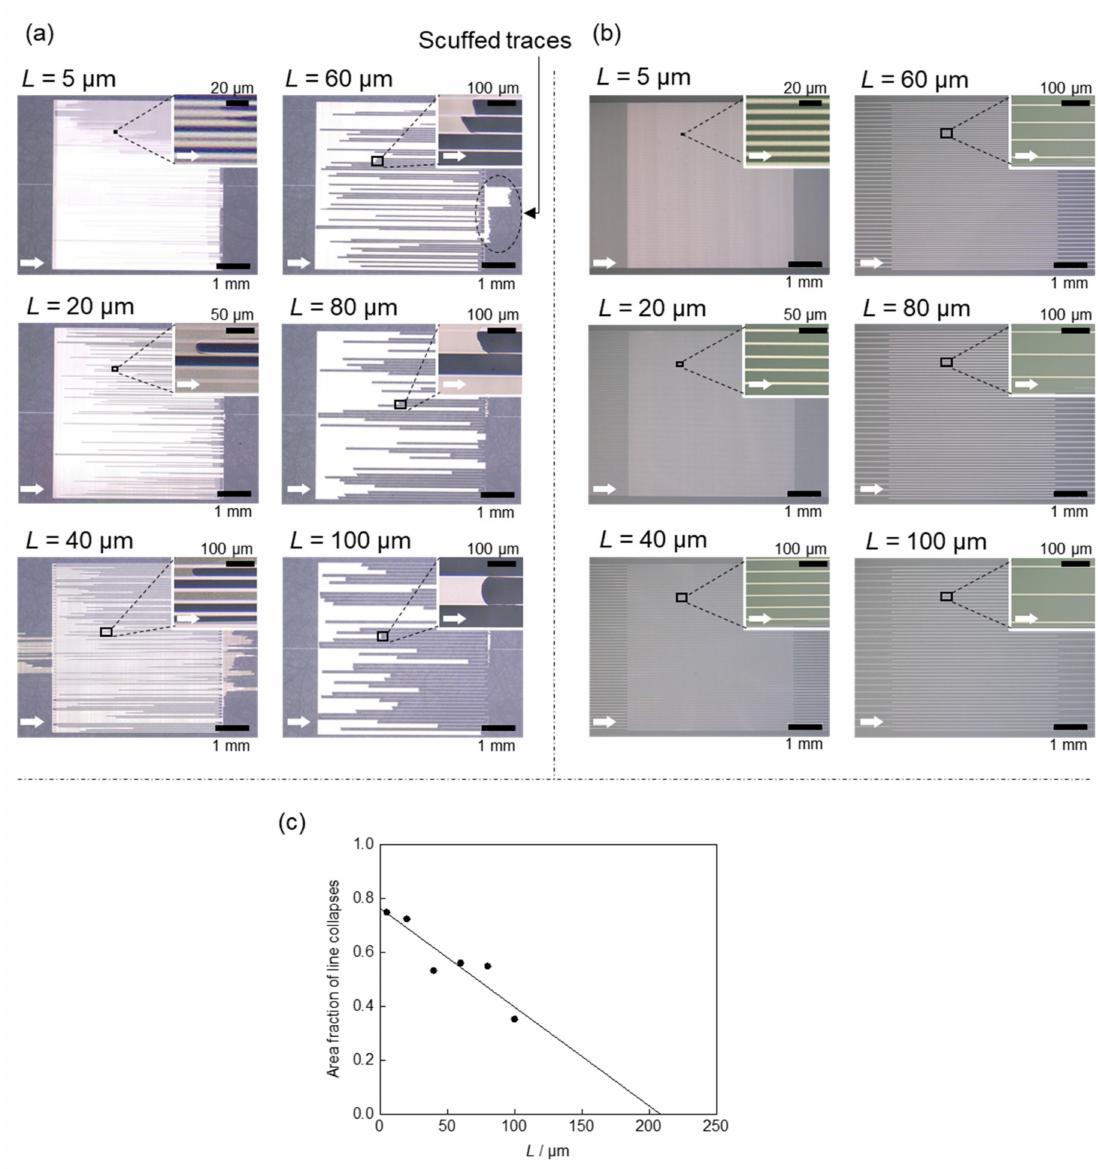
Figure 2. Optical micrographs for different designs of interdigitated array electrodes fabricated by nanoparticle chemisorp- tion printing: ( a ) closed edge and ( b ) opened edge. The white arrows indicate the blade-sweep direction during the nanoparticle chemisorption printing. ( c ) Area fraction of line collapses, plotted as a function of electrode gap ( L